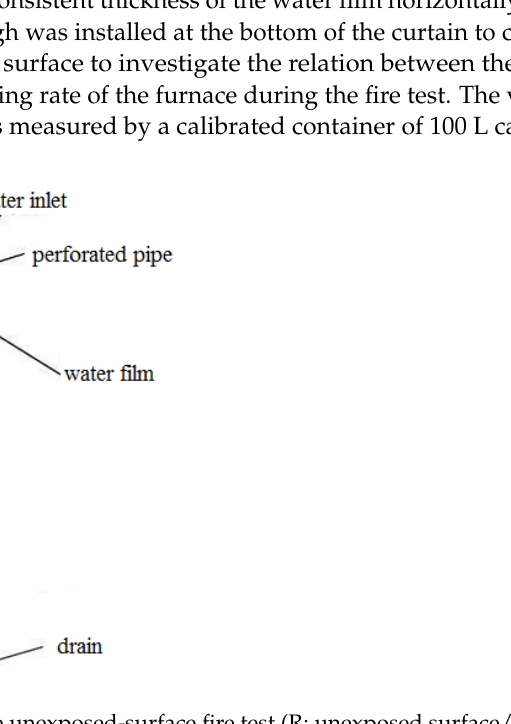
Figure 4. Schematic of the unexposed-surface fire test (R: unexposed surface/L: exposed surface).